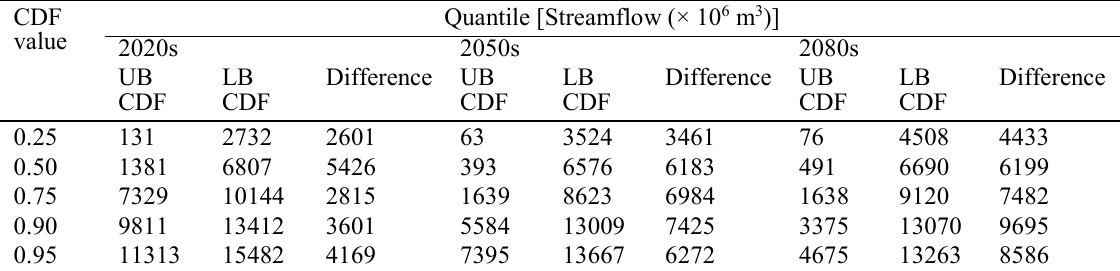
Fig. 4 Cumulative distributions of monsoon streamflows in the Mahanadi River from different models and scenarios (source: Mujumdar and Ghosh 2008). Table 1 Uncertainty in projections of Mahanadi streamflows (million cubic metre) at Hirakud Dam (source: Mujumdar and Ghosh 2008). LB = Lower bound; UB = Upper Bound; CDF = Cumulative probability